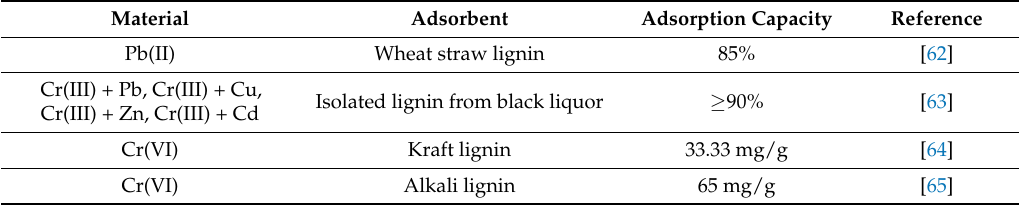
Table 3. Lignin potential in heavy metal